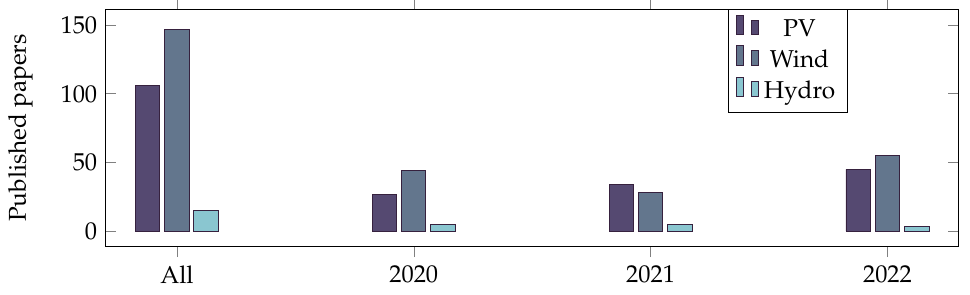
Figure 4. Annual distribution of published journal papers concerning machine learning applications in prediction of electricity generation from various RES (papers search last updated in October 2022).